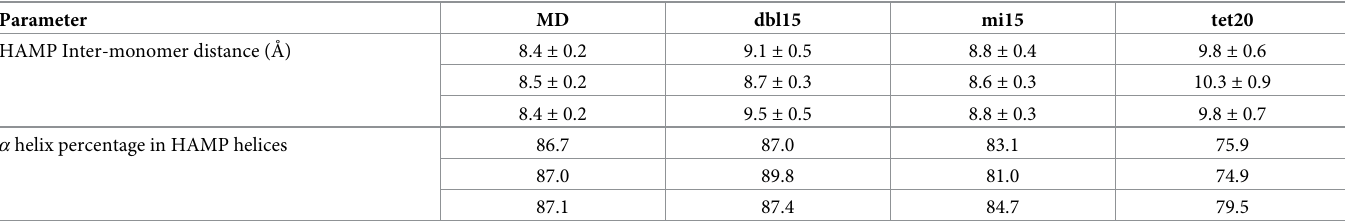
α helix percentage in HAMP